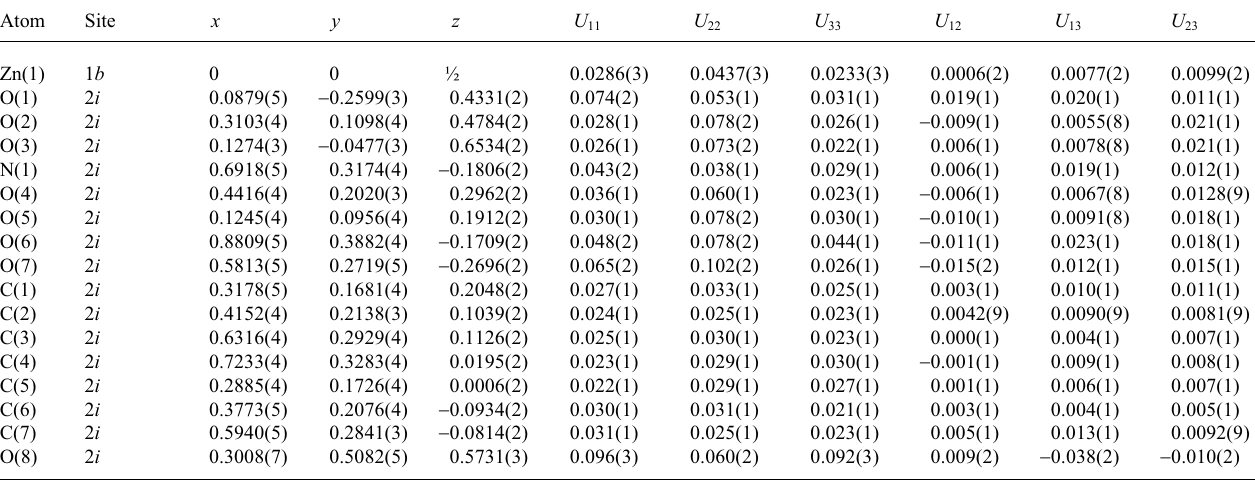
Table 3. Atomic coordinates and displacement parameters (in Å 2 )